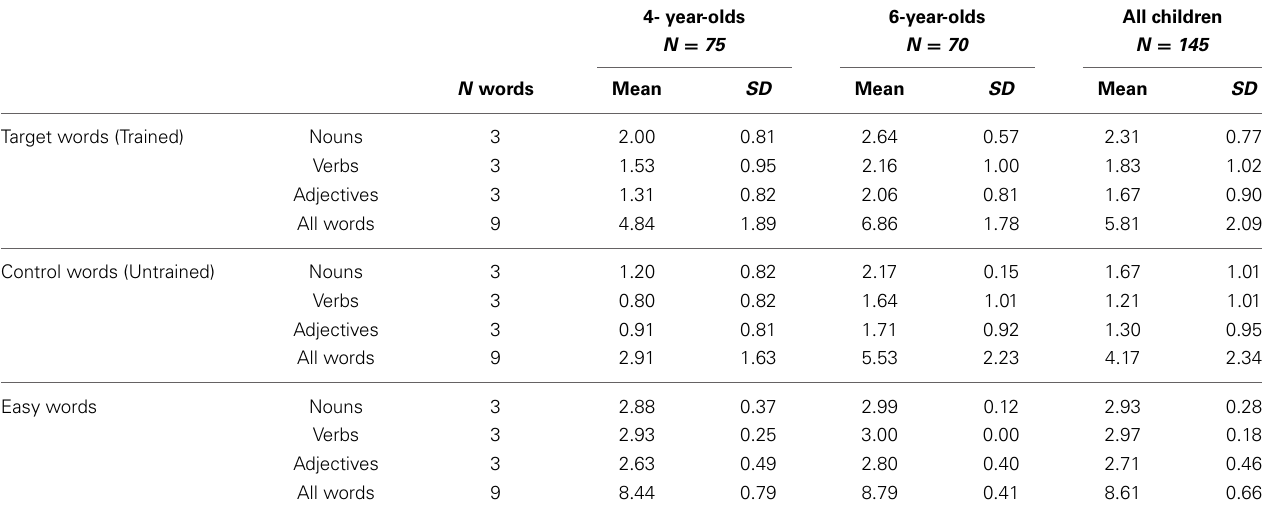
Table 1 | Mean number of correct responses to each set of words in the forced-choice comprehension task.